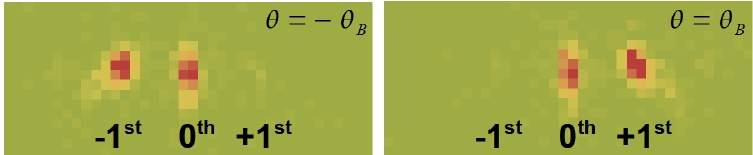
Figure 4. Diffraction pattern at two different incident angles θ . Grating parameters: ≈ 185 µ m, 20 vol% SiO Λ = 1 µ m, d nanoparticles. The used wavelength 0 2